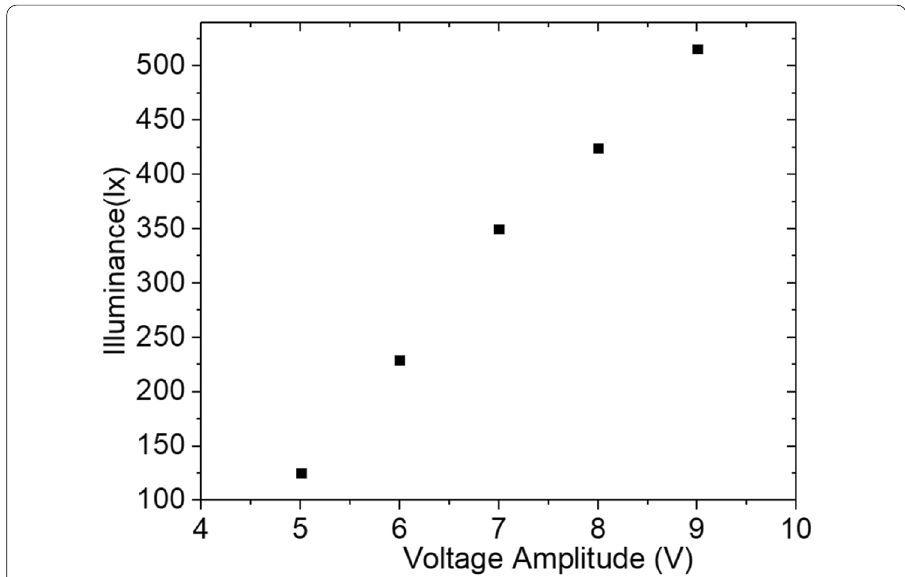
Fig. 3 Illuminance versus voltage amplitude of LED device under “constant heatsink temperature and constant bias voltage”